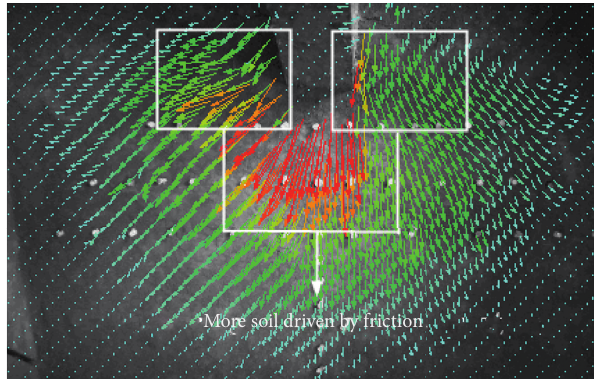
Figure 13: Horizontal Diffusion Principle.